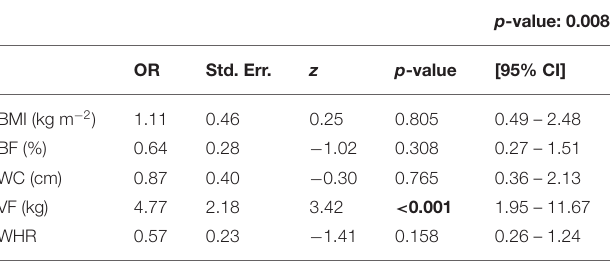
TABLE 7 | Logistic regression analysis reporting odds ratios of water expenditure risk regarding average healthy diet water footprint (WF) and adiposity indicators.